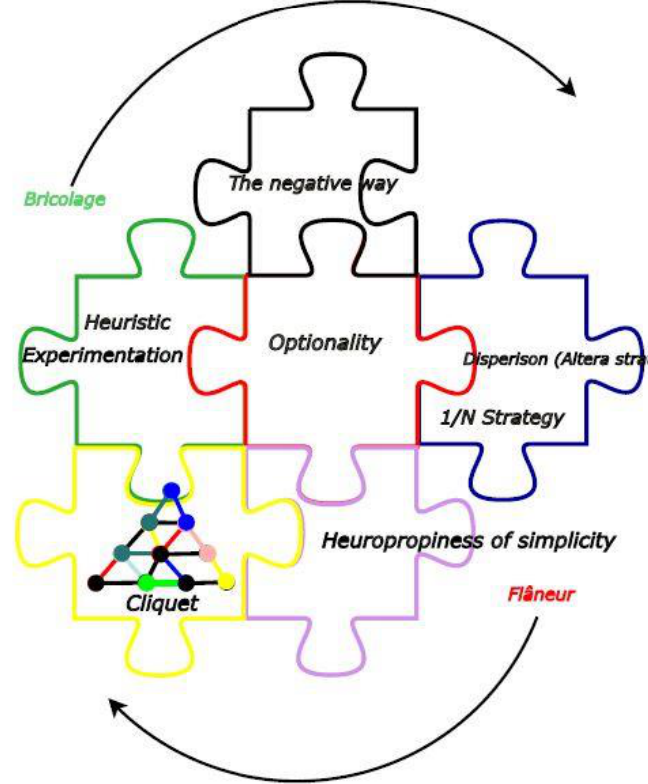
Figure 2. Main antifragile properties.